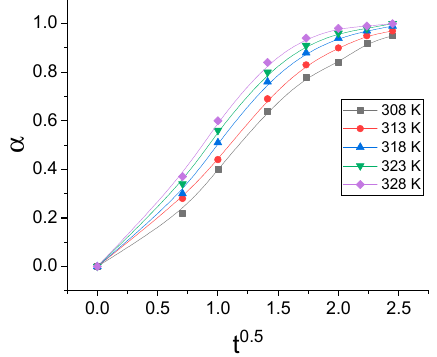
Figure 2. Isothermal dependence of α on t 0.5 .